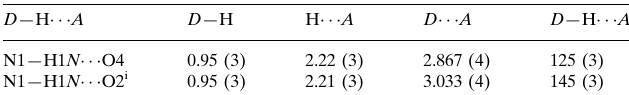
Hydrogen-bond geometry (A˚ , (cid:4)